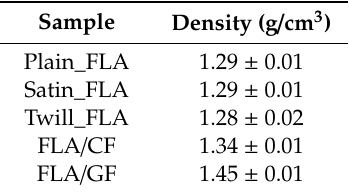
Table 4. Density values of